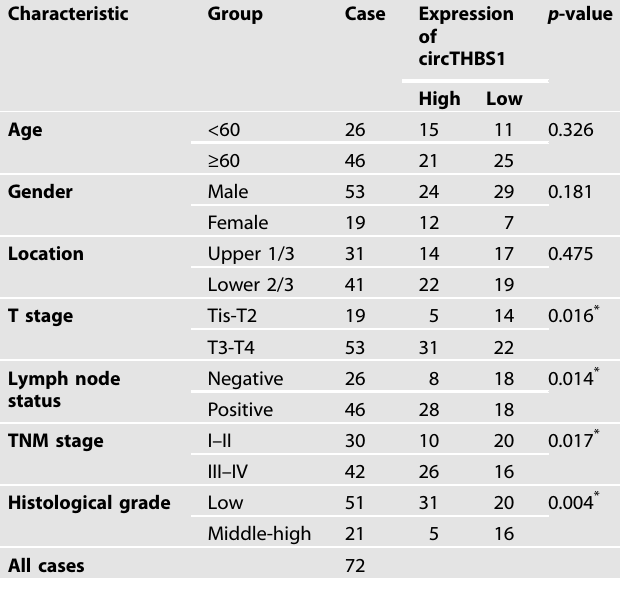
Table 1. Correlation between circTHBS1 expression and the clinicopathologic parameters in 72 GC